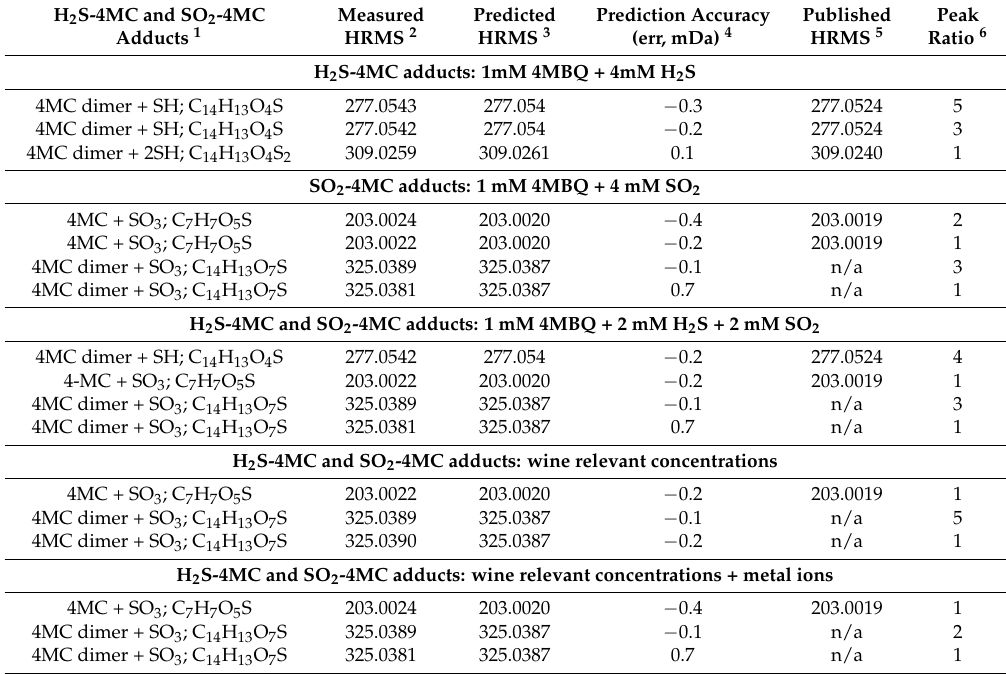
Table 2. Mass spectral data and retention times of adducts of 4-methyl benzoquinone with H 2 S and SO 2